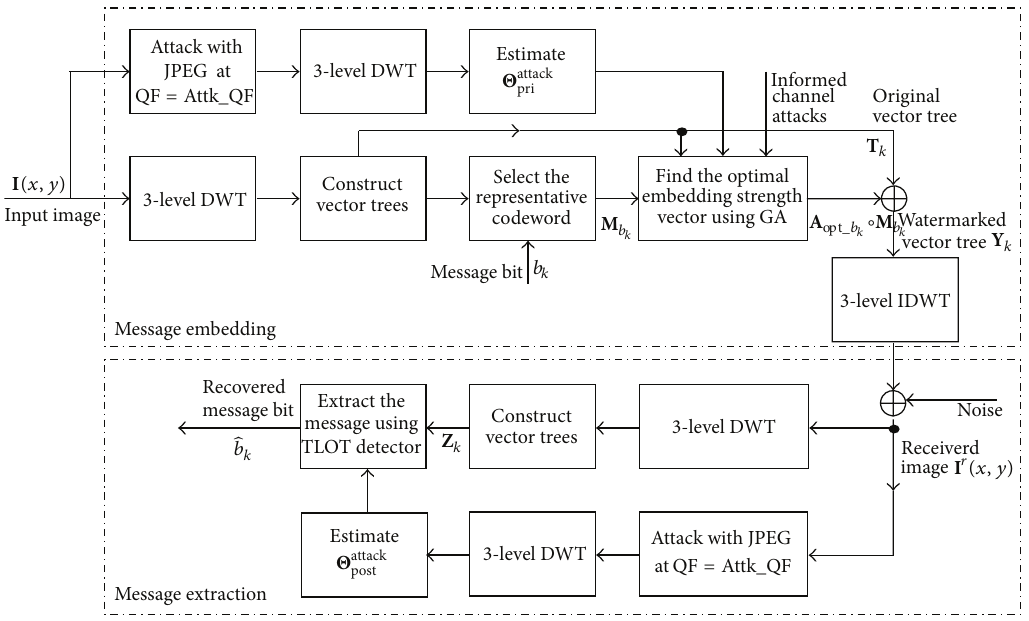
Figure 4: Block diagram of the proposed